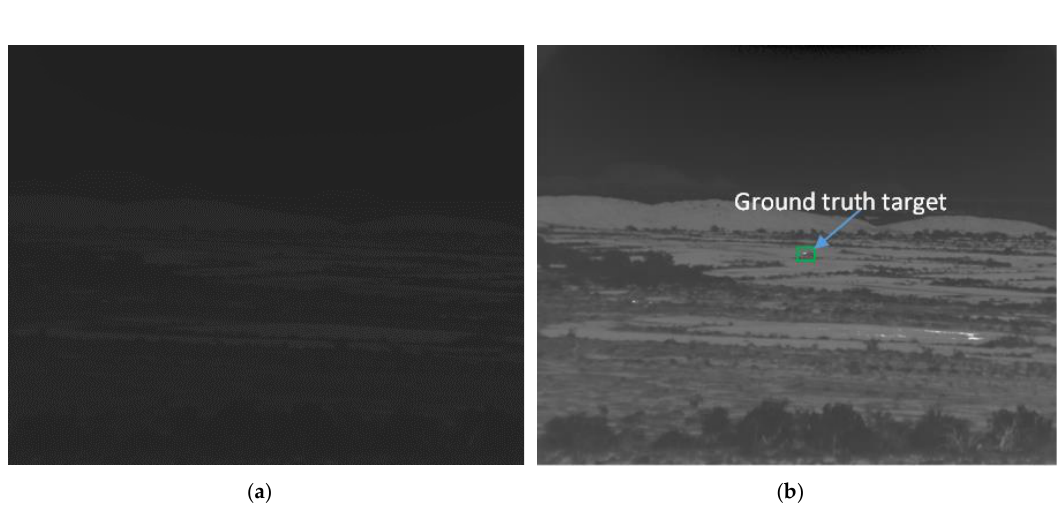
Figure A1. 16-bit raw frame.